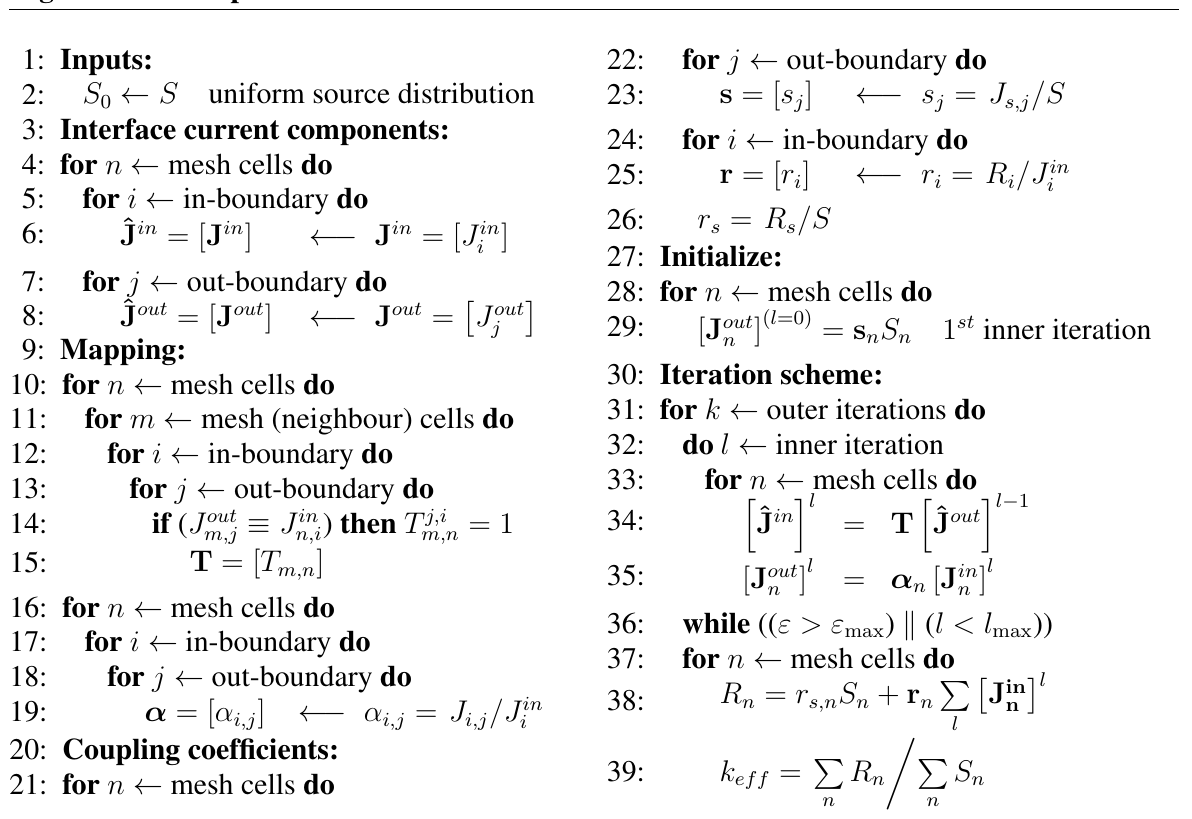
Algorithm 3: Response matrix